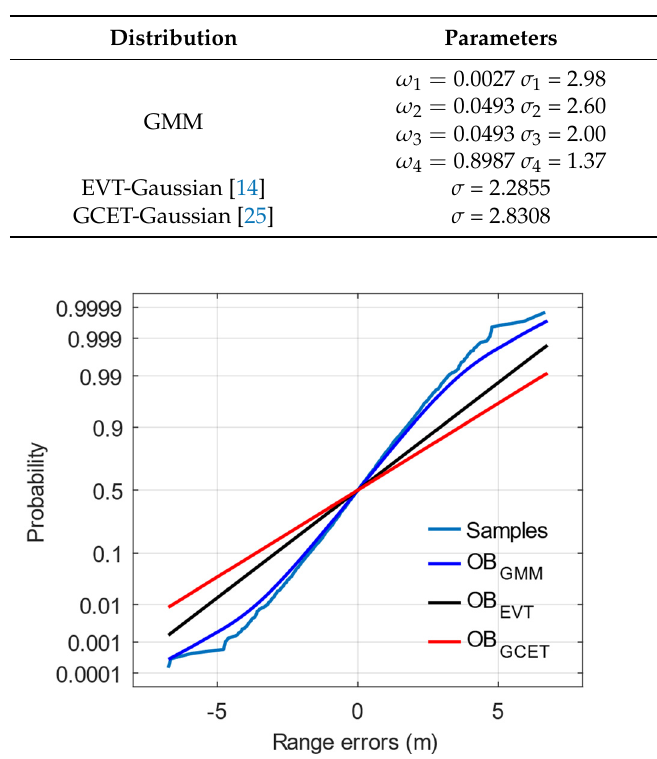
Table 6. Distribution parameters of different overbounds at elevation bins from 15 ◦ to 20 ◦ .